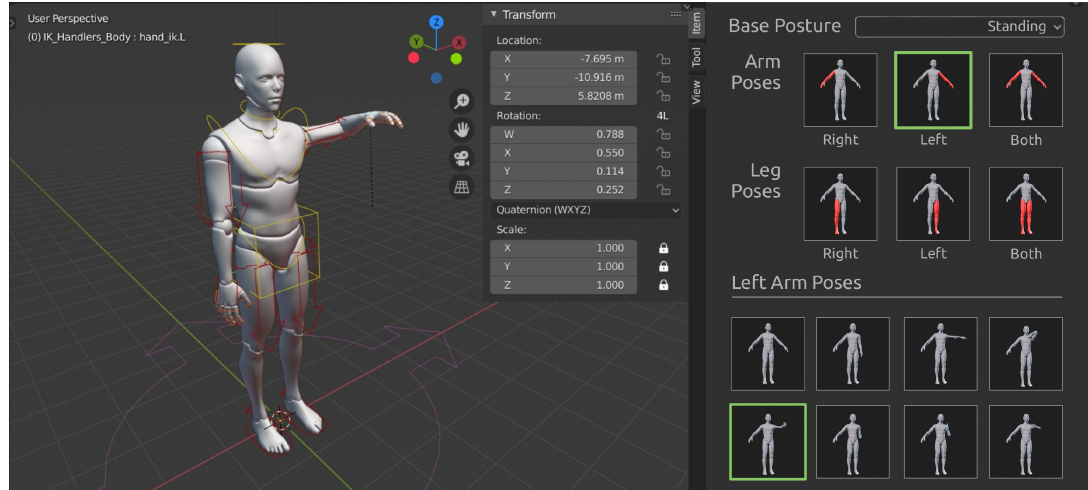
Figure 3. Pose editor of the proposed graphical tool. On the right, a subset of poses available for the arm is shown.